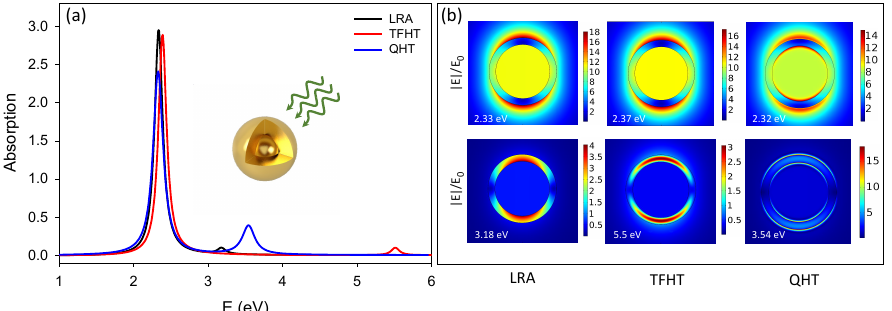
Figure 7. ( a ) Absorption efficiency of Au nanoshell with R 1 = 2 nm and R 2 = 2.5 nm calculated using LRA, TFHT, and QHT. ( b ) Electric field distribution plotted at corresponding resonance frequencies both at lower (upper panel) and higher energy modes (lower panel) computed using different